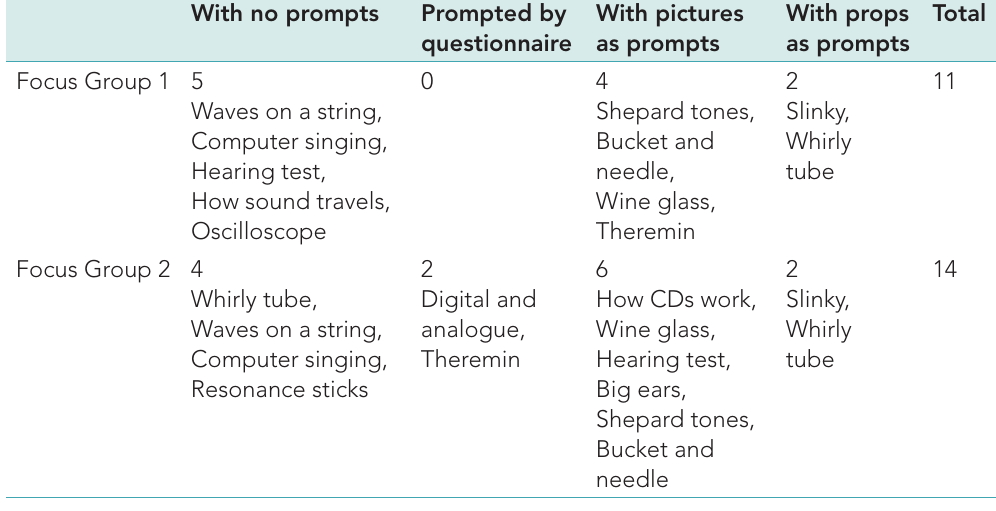
With pictures With props Total questionnaire as prompts as prompts